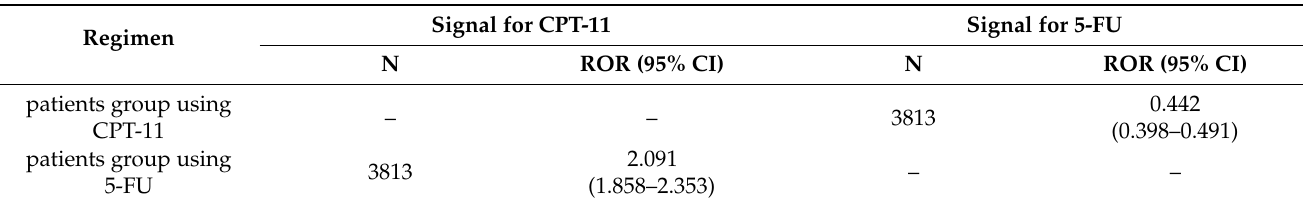
Table 4. Subset analysis for the detection of diarrhea induced by irinotecan (CPT-11) and 5-fluorouracil (5-FU) due to a drug–drug